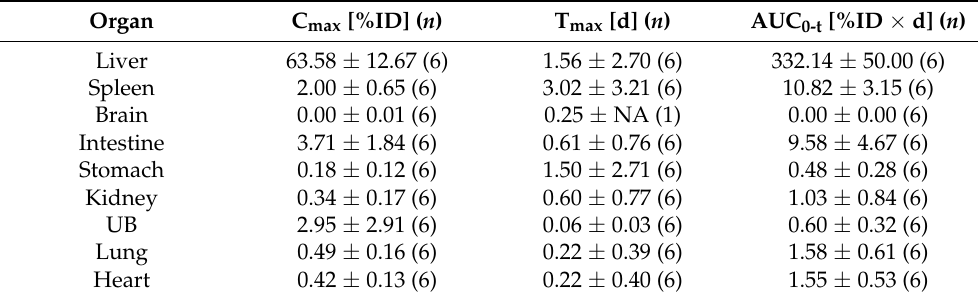
Table 3. In vivo pharmacokinetic parameters of 89 Zr-Exo following i.v. administration in various organs of SD